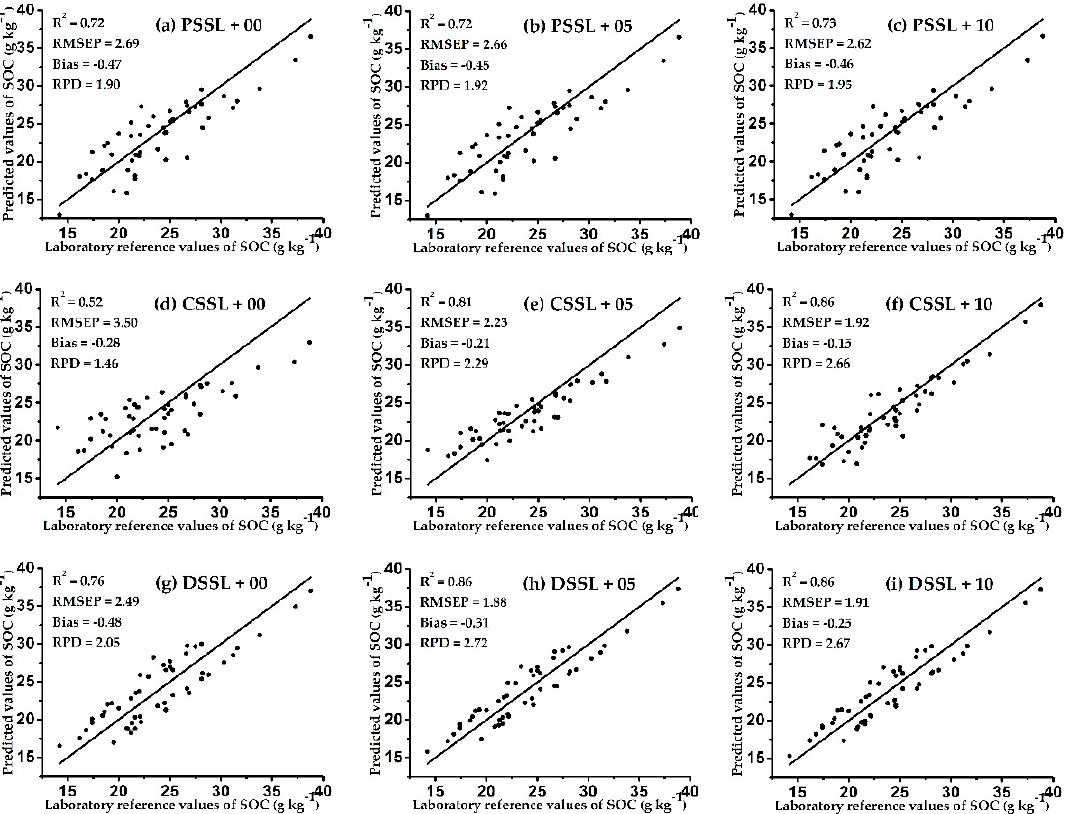
Figure 4. Scatter plots of predicted values and laboratory reference values of SOC of TA1 pre by each model. Scatter plots ( a , d , g ) show the prediction effect of the UMs; ( b , e , h ) show the SMs with 5 spiking samples from the target area; and ( c , f , i ) show the SMs with 10 spiking samples from the target area.